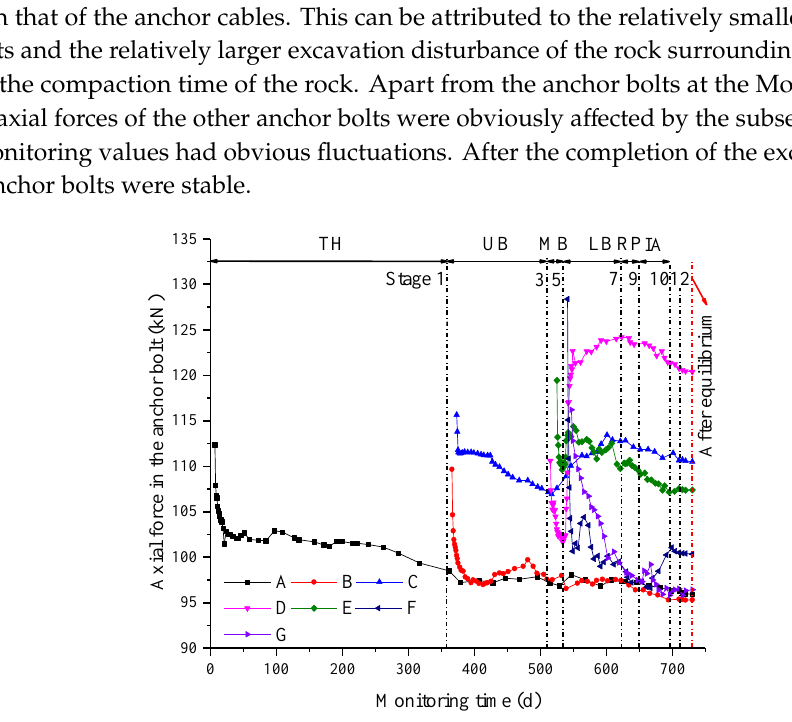
Figure 20. Final distribution of the axial forces in the cables.